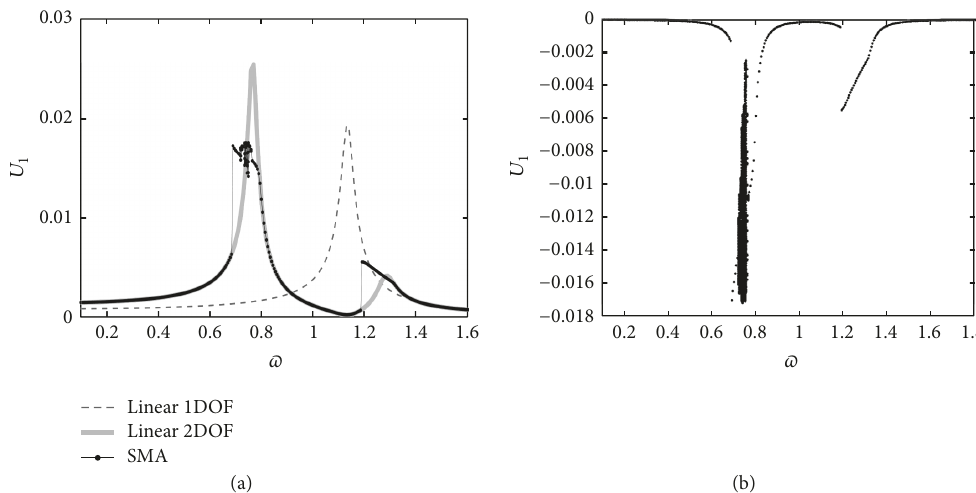
Figure 5: Primary system response with 𝛿 = 0.0011 and 𝛾 𝑚 = 0.15 in down-sweep test: (a) maximum amplitude; (b) bifurcation diagram.